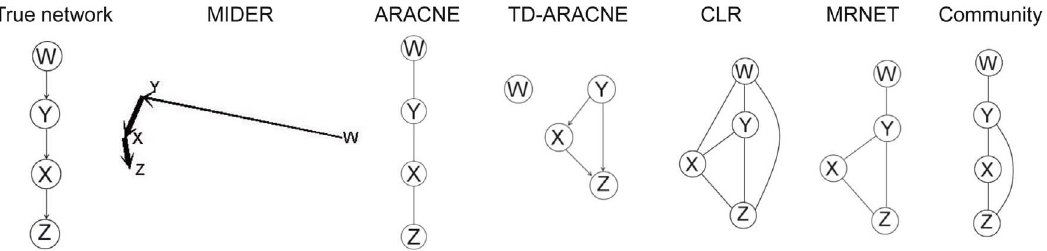
Figure 7. Benchmark B3. Reaction chain with 4 species.